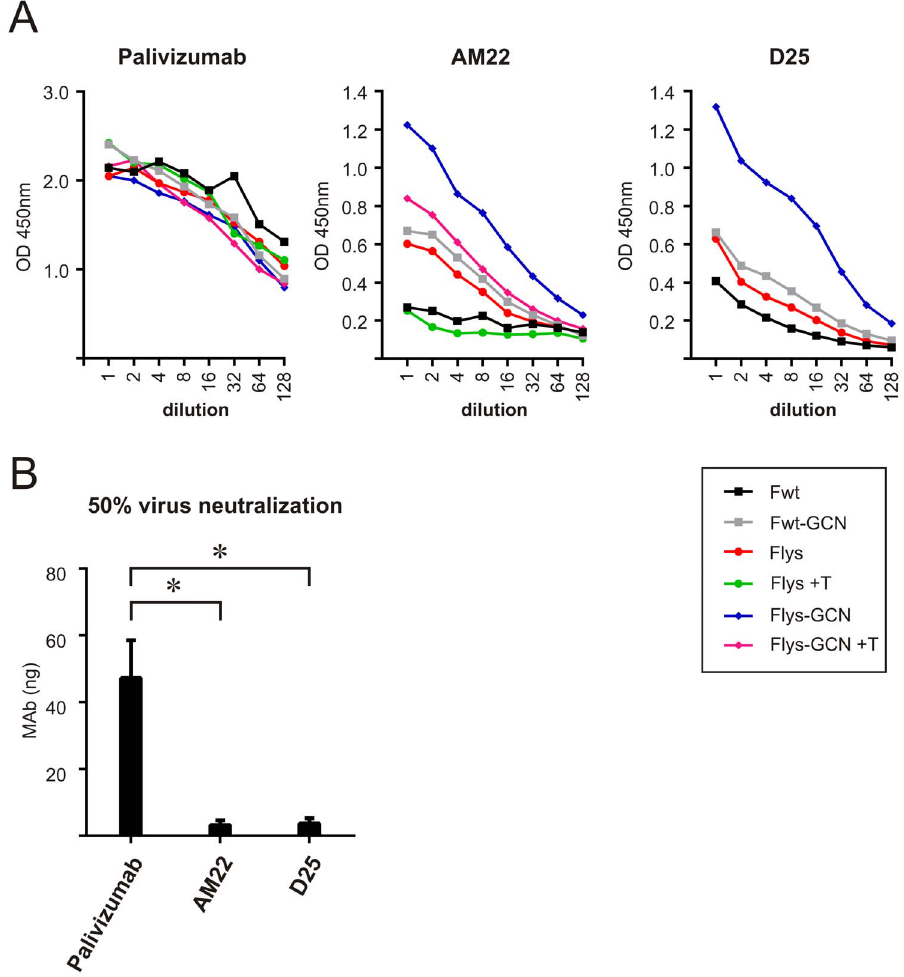
Figure 4. Reactivity of recombinant F proteins with neutralizing antibodies. A) ELISA analysis of recombinant F proteins. Purified F proteins were coated on 96-well plates; when indicated samples were treated with TPCK trypsin ( + T) prior to coating. The reactivity of the recombinant proteins with different neutralizing MAbs was analyzed by applying 2-fold serial dilutions of Palivizumab (starting with 0.375 m g/ml), AM22 (starting with 3.5 m g/ml) or D25 (starting with 5 m g/ml). Binding of the antibodies was detected using HRP-conjugated secondary antibodies. Fwt-GCN and Flys-GCN contain a C-terminal LysM domain and ST3 tag. Fwt and Flys contain a C-terminal ST3 tag. B) Neutralization of RSV by MAbs. The amount needed of each MAb to achieve 50% neutralization of virus infectivity is graphed. The error bars indicate the standard deviations (* P , 0.05 in Student’s t test).